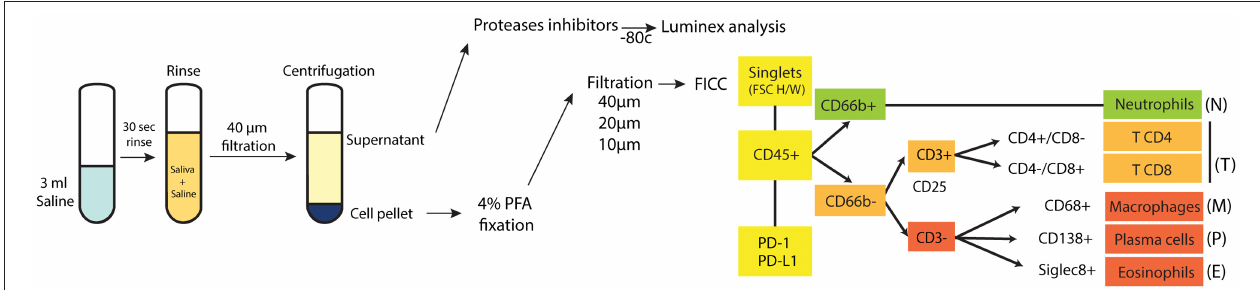
FIGURE 1 | Study protocol. A diagram showing the protocol for collecting and analyzing saliva samples, with the gating strategy used to identify and quantitate each inflammatory cell type.